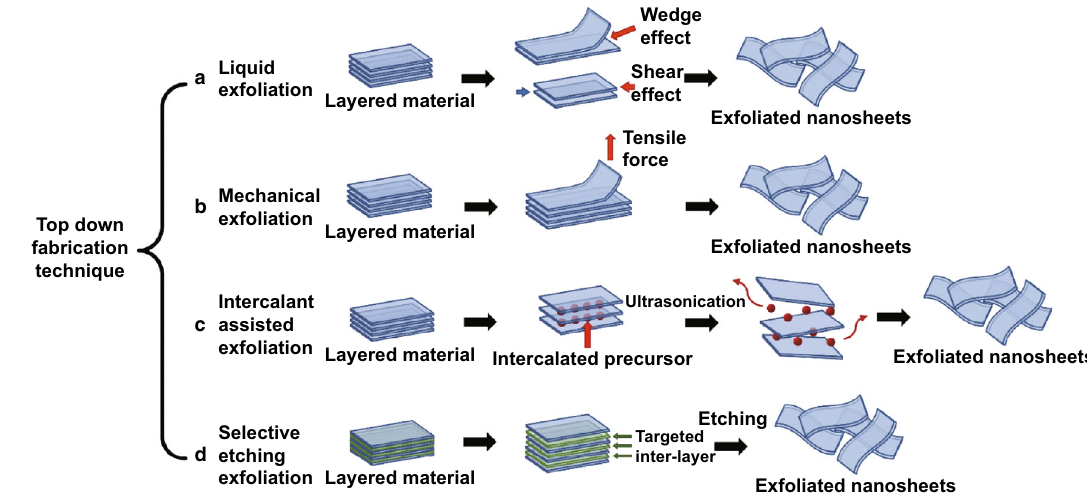
Fig. 4 Schematic representation of various ‘‘top-down’’ fabrication techniques for large-scale synthesis of electrode materials: a Liquid exfoliation where the sheets are sheared off by sonicating the bulk material in a liquid medium. b Mechanical exfoliation, whereby a tensile force (possibly produced by Scotch tape) can peel off the constituent layers. c Intercalant-assisted exfoliation where a metal ion (usually Li ? ) is used to intercalate into the bulk precursor in a liquid media coupled with ultrasonication, which shears the sheets apart. d Selective etching, in which an etchant (usually strong acids, e.g., HF) is used to remove one or more constituent atoms and result in the formation of